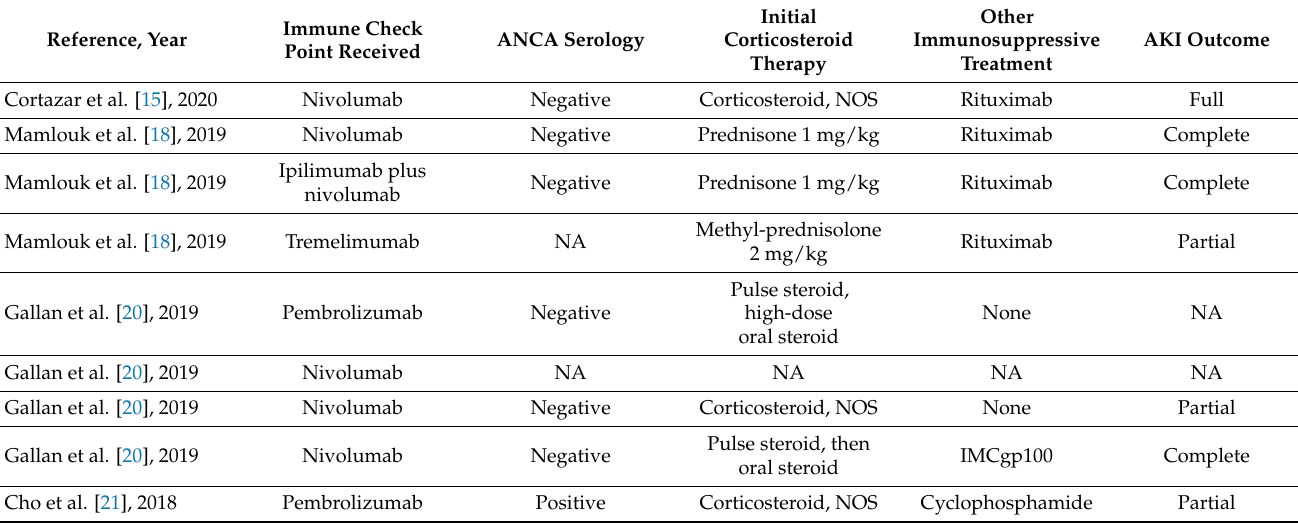
Table 1. Published reports of pauci-immune glomerulonephritis and renal vasculitis associated with immune checkpoint inhibitor